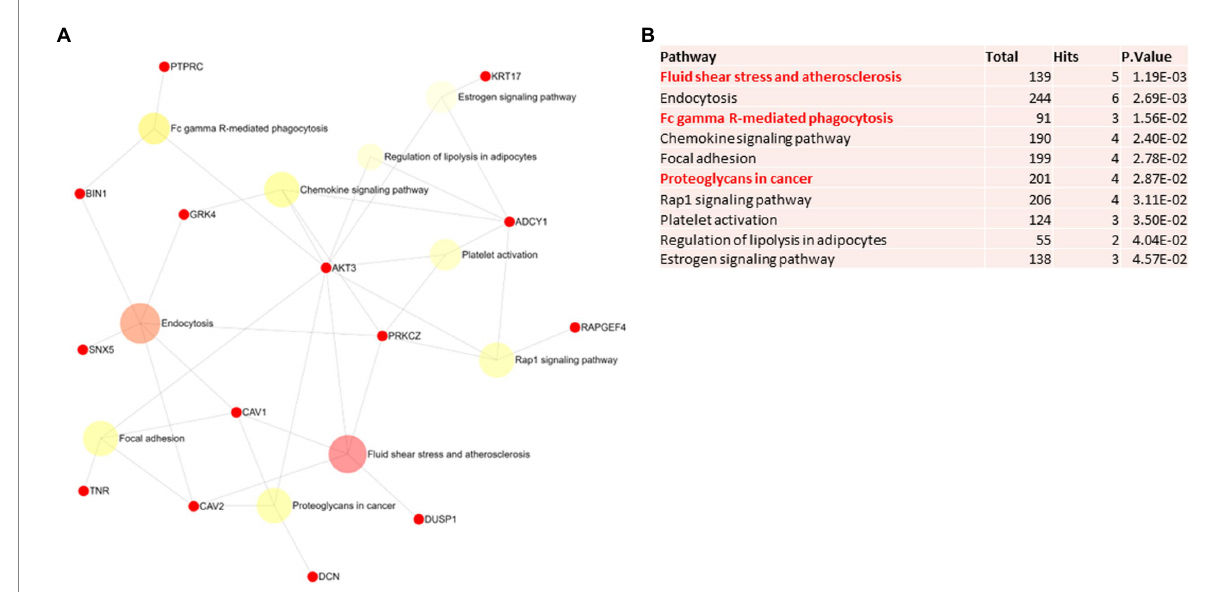
FIGURE 6 Pathway analysis of switch genes from asymptomatic males with Alzheimer’s disease (M-asymAD). (A) Biological and functional analysis of switch genes from M-asymAD compared to controls was performed in NetworkAnalyst. Switch genes are depicted in red. (B) The pathways are ranked according to the number of hits and lowest value of p. Pathways are derived from the KEGG database. The unique pathways are shown in